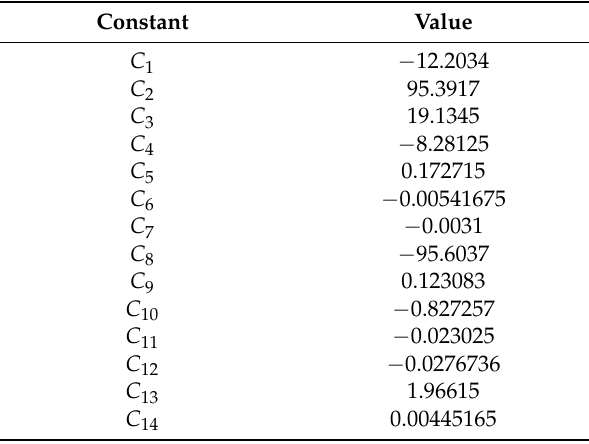
Table 5. Values of the equation